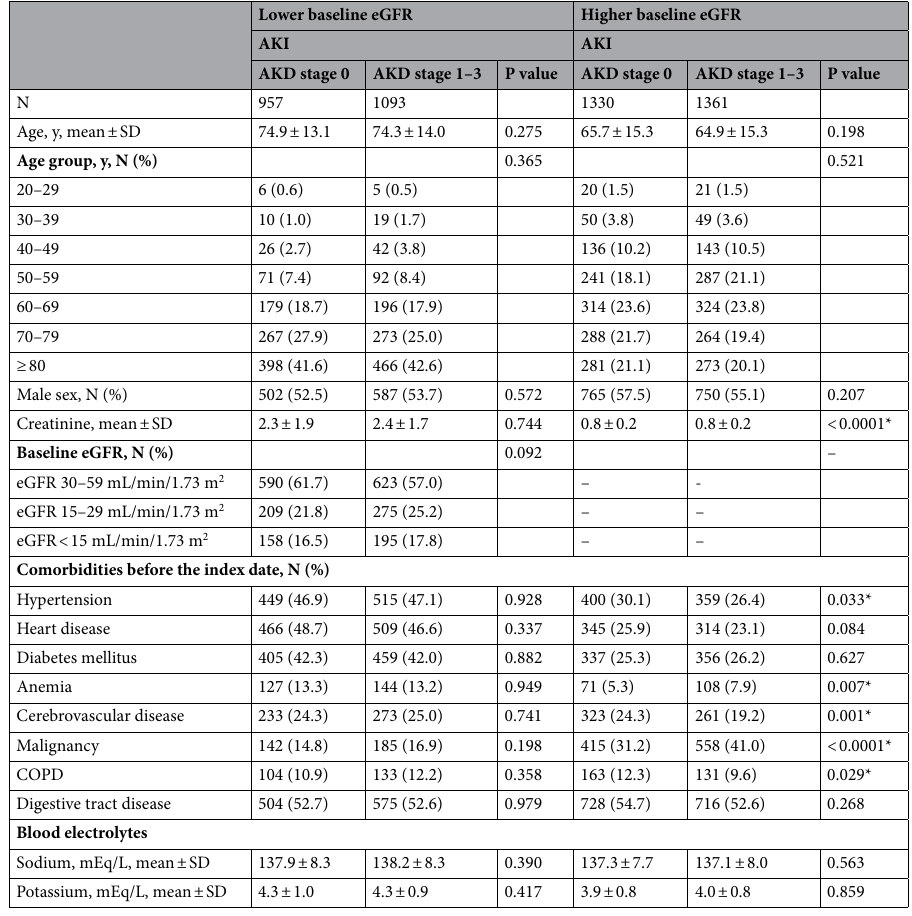
Table 1. Characteristics of AKI patients with different baseline eGFR classification and AKD status. *P < 0.05. SD standard deviation, eGFR estimated glomerular filtration rate, AKI acute kidney injury, AKD acute kidney disease, COPD chronic obstructive pulmonary